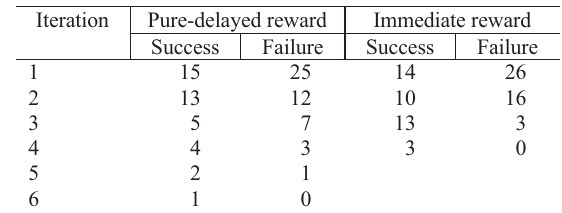
Table 3. The number of training iterations for two reward schemes when 𝑛 equals 7